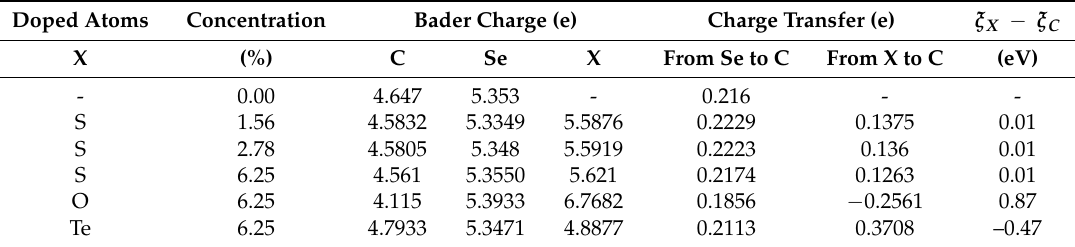
Figure 6. Projected densities of states (PDOS) of monolayer CSe: ( a ) pristine monolayer; ( b – d ) S-doping cases at concentrations of 1.56%, 2.78%, and 6.25%, respectively; ( e ) O-doping at 6.25%; ( f ) Te-doping at 6.25%. VBM is set at zero. Table 3. Bader charge of X and C atoms, net charge transfer, and the difference in electronegativity ( ξ X − ξ C ) between X and C atoms in X-doping C X